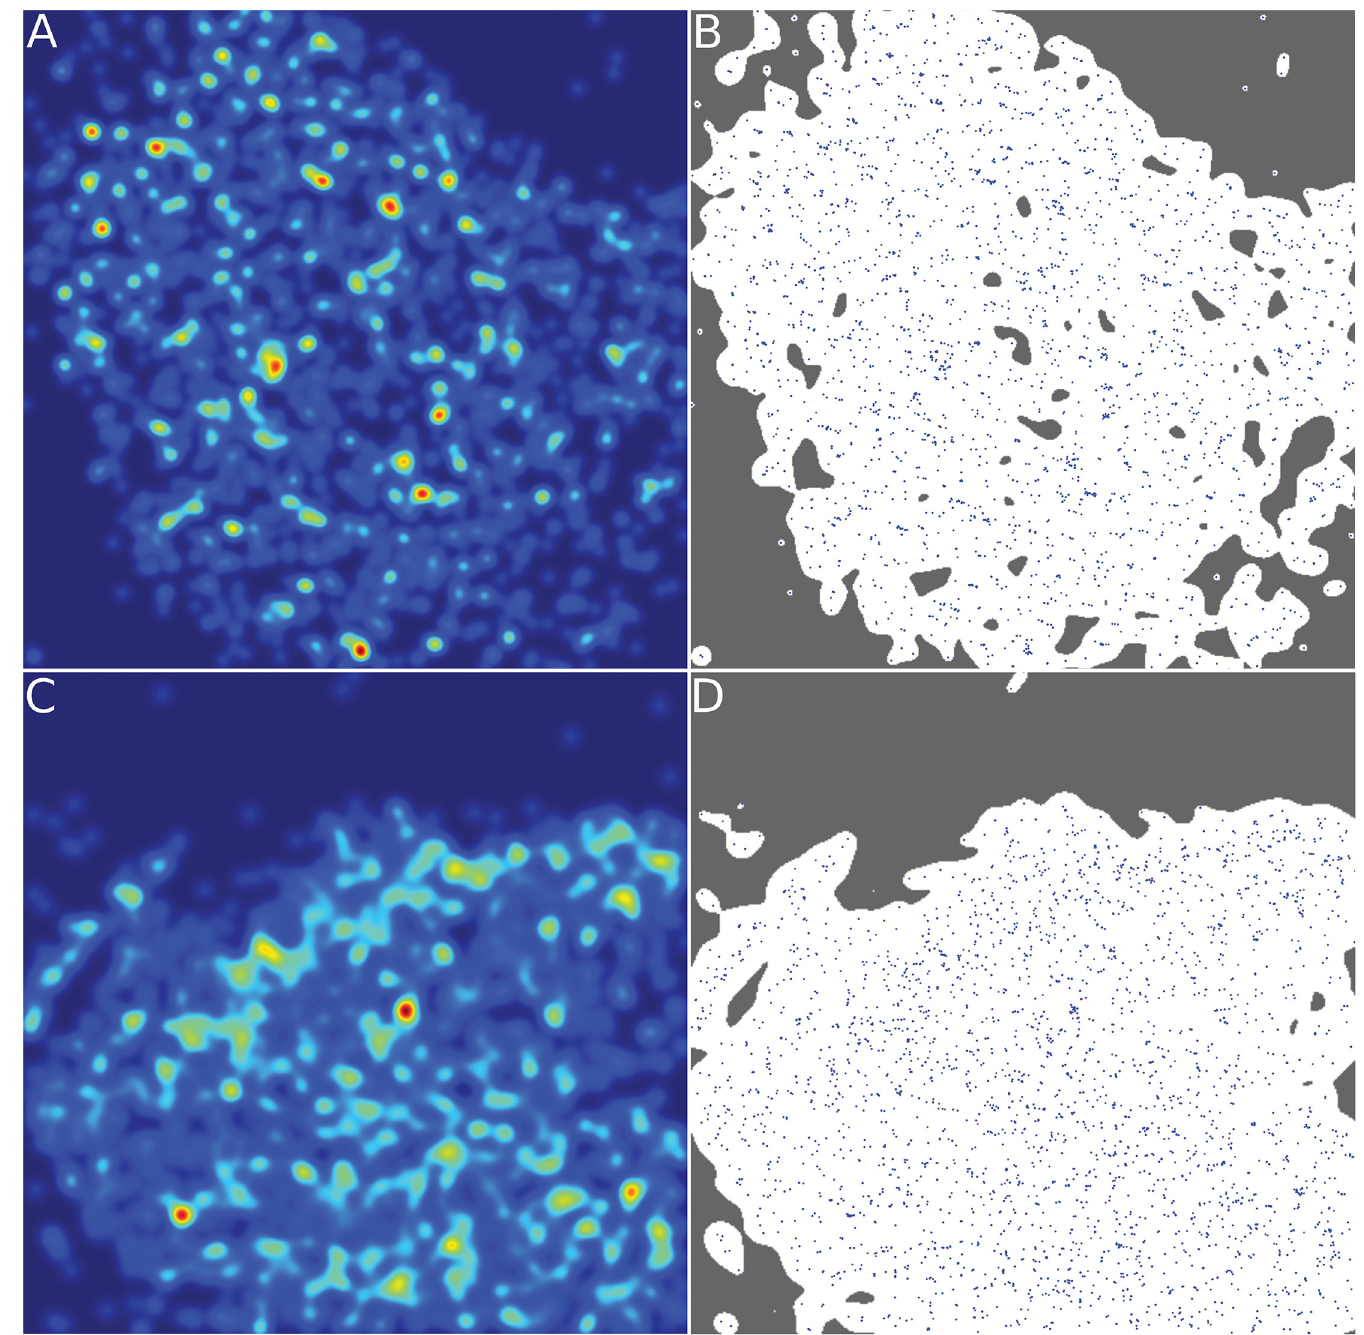
Fig 6. Examples of Localization Microscopy Images of Heterochromatin Markers. Panel A. Shown is the density distribution of the localized markers in a cell prior to irradiation. Small, very bright spots where markers are agglomerated can be seen. This means that heterochromatin is mainly organized in coarse areas. Panel B. Shown is the segmented image of the not irradiated cell that is used for subsequent analysis of the marker distribution. Panel C. The density distribution of a cell at 30 min after irradiation with 0.5 Gy is shown here. Differences between this cell and the not irradiated cell can be made out by visual inspection. We observe that the density has much less agglomerated and bright spots and is instead much more homogeneous. Panel D. This effect can also be seen by visual inspection of the heterochromatin markers directly. Marker positions are visibly more spread out and less strongly clustered together. Heterochromatin clearly undergoes structural changes upon